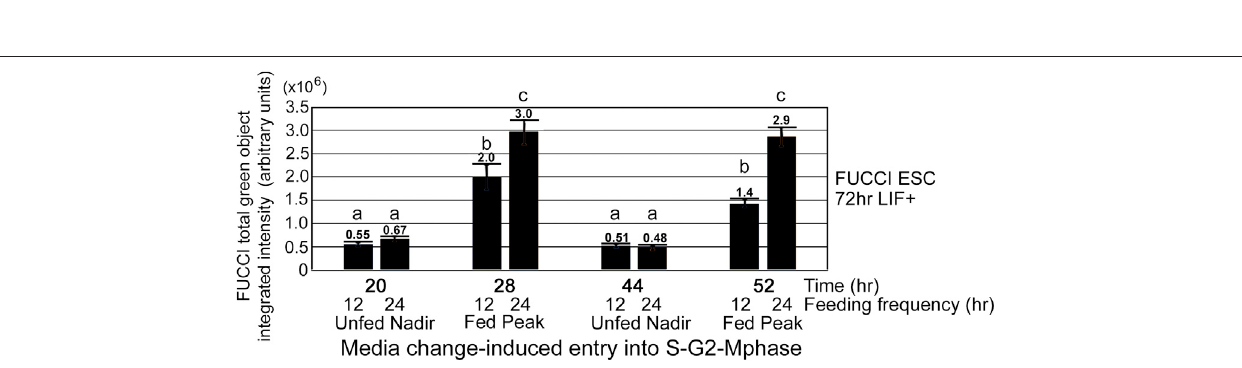
FIGURE 2 | The stimulation index of 24-h feeding frequency peak is greater than the 12 h-feeding frequency peak. (A) FUCCI ESCs enter the S-G2-M phase after mediumchange.24-hfeedingfrequencyhasmorecellsenteringtheS-G2-Mphaseafter mediumchangethandoes12-hfeedingfrequency.FUCCIESCs werepassed into96-wellplatesandhad fi rstmediumchangeofNS/LIF+mediaatTzero,werefedat24and48 hor12,24,36,48,and60 h,andthenassayedforFUCCItotalobject green intensity in an IncuCyte Zoom liveimager at the times indicated. Statistical comparisons from fi ve or six independentbiological experiments for 12- and 24-h feedingfrequency,respectively:a,b),aisnotsigni fi cantlydifferentthanb,butbat44-htimepointisasigni fi cantlylowernadirthan bat20-htimepoint( p < 0.01),c.)12-h peak is signi fi cantly higher than 12-h nadir ( p < 0.0001), and d.) 24-h feeding frequency peaks are signi fi cantly higher than 12-h frequency peaks ( p < 0.05). Same N as shown in Figure 1